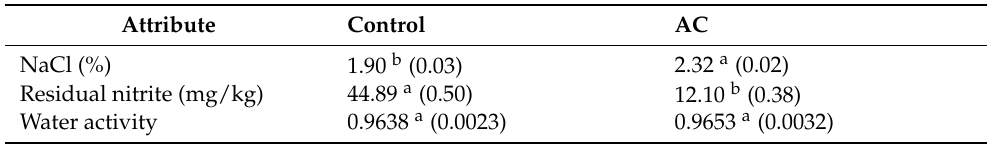
Table 2. Comparison of the control (produced with the direct addition of nitrite) and alternatively cured (AC) sausages (mean values and standard deviation in the brackets). Attribute Control NaCl (%) Water activity a,b values in rows with different letters differ significantly at p <